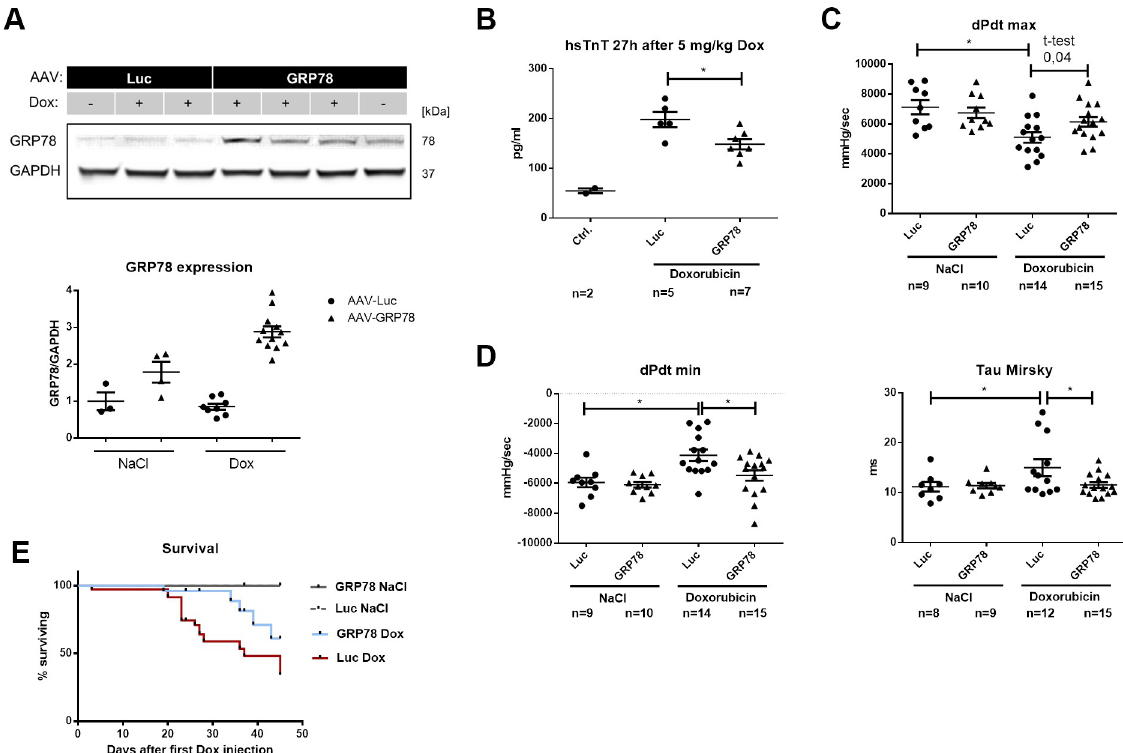
Fig 7. Effect of glucose regulated protein 78 (GRP78) genetransfer on cardiac function and survival in vivo . Male C57/Bl6N were transfected with 2.5 � 10 12 viral genomes of a virus expressing GRP78 or Luciferase (Luc). Then they were injected with a cumulative Doxorubicin (Dox) dose of 20 mg/kg or NaCl over 3 weeks. ( A ) GRP78 expression 8 weeks after transfection. Glyceraldehyde 3-phosphate dehydrogenase (GAPDH) was used as housekeeping gene. Luc NaCl n = 3; GRP78 NaCl n = 4; Luc Dox n = 8; GRP78 Dox n = 12. ( B ) Plasma high sensitive Troponin T (hsTnT) levels 27h after the last Dox injection for determination of cardiomyocyte death (n for each group is depicted in the Figure). ( C ) Catheter based intraventricular assessment of minimal (dP/dtmin) pressure velocity as parameter for systolic function (n for each group is depicted in the Figure). ( D ) Catheter based assessment of diastolic ventricular function. Dox induced changes in minimal (dP/dtmin) and maximal (dP/dtmax) pressure velocity and relaxation parameter Tau Mirsky (n for each group is depicted in the Figure). � p < 0.05 for 1-way ANOVA with Bonferroni post hoc testing. ( E ) Overall survival after Dox treatment in all groups. Luc NaCl n = 10; GRP78 NaCl n = 10; Luc Dox n = 29; GRP78 Dox n = 25. � Log-rank (Mantel-Cox) Test t (P =